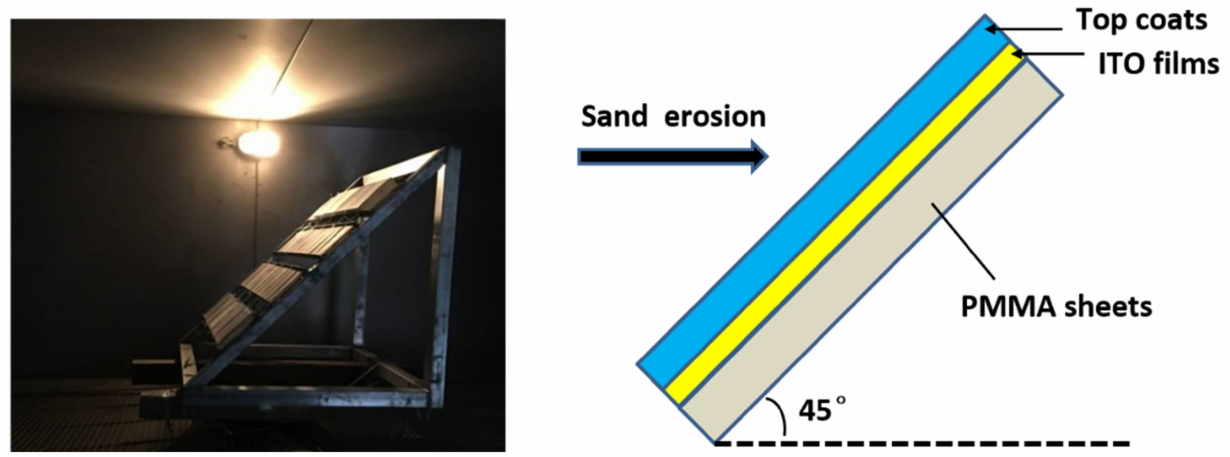
Figure 1. The picture of sand erosion